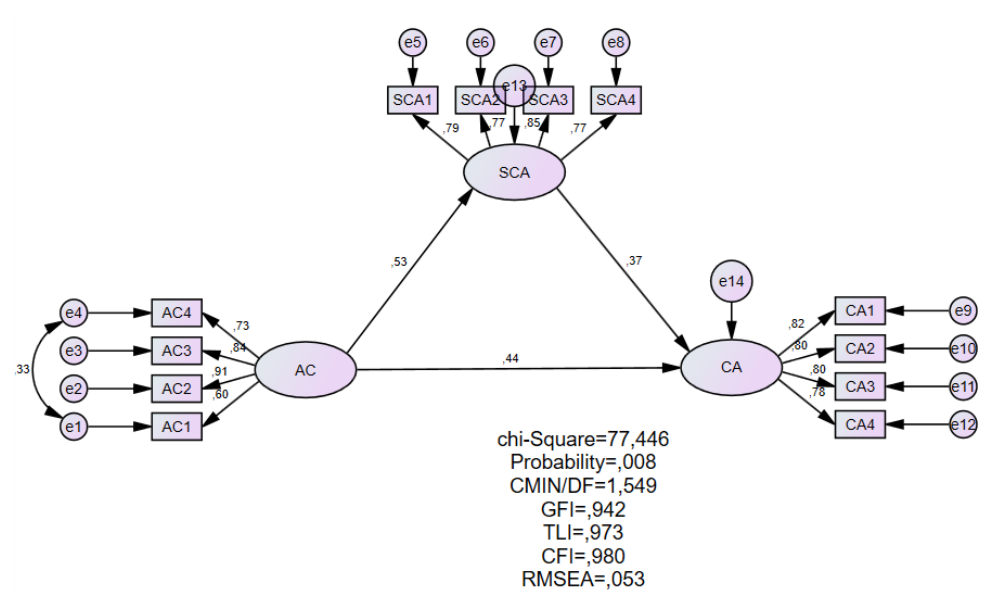
Figure 2: Model Result; Source: Data